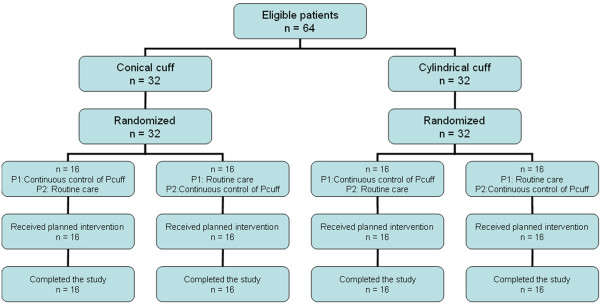
Study flowchart. Pcuff, cuff pressure; P1, period 1; P2, period 2.